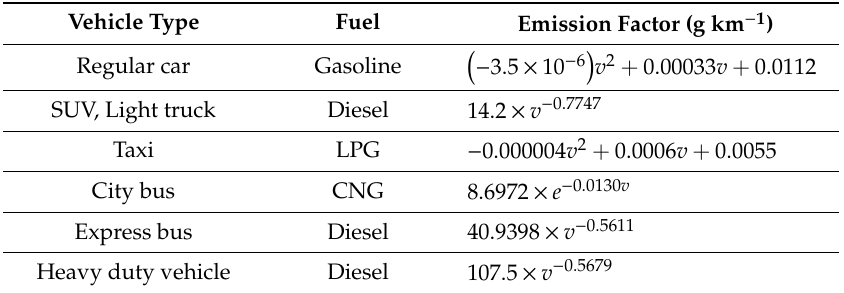
Table 2. NO x emission factors classified by vehicle type in CAPSS ( v = driving